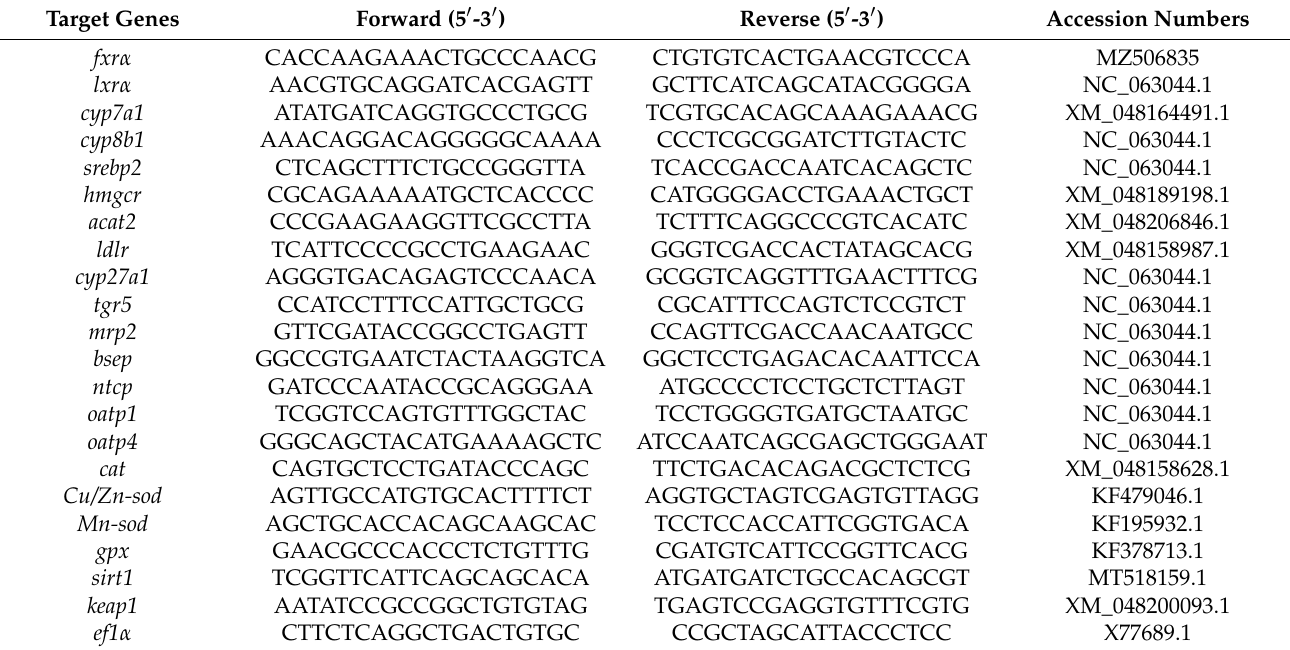
Table 2. Nucleotide sequences of the primers used to assay gene expressions by real-time